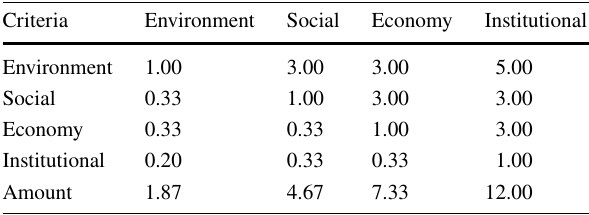
Table 2 Matrix pairwise comparison of criteria Criteria